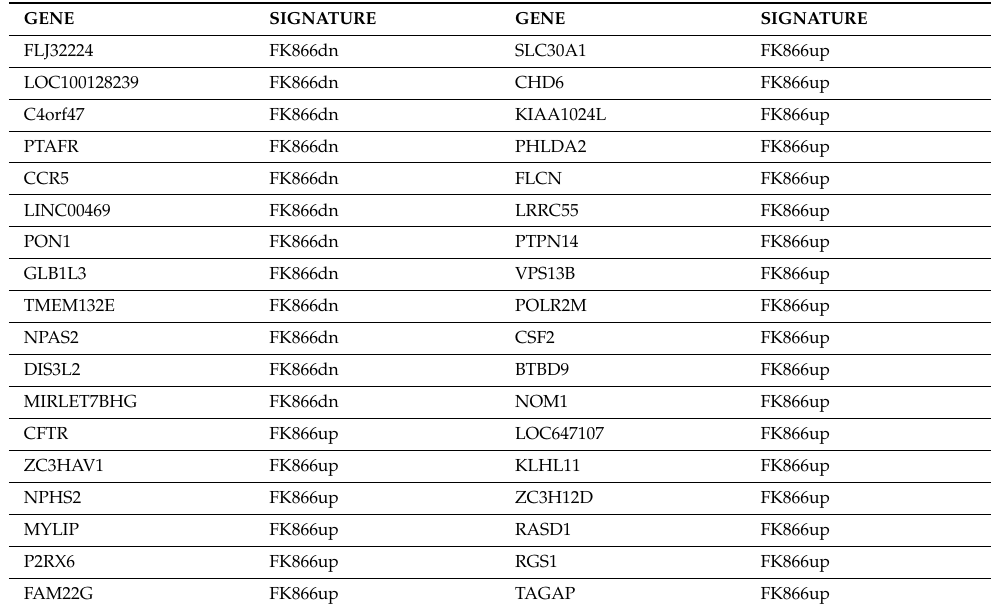
Figure 3. FK866 transcriptomic changes among CD38-overexpressing MM patients confers survival advantage. ( A ) Heatmap showing FK866 activity signature expression in NDMM patients derived from the CoMMpass dataset: a group of patients with gene expression in accordance with FK866 treatment is highlighted in the green rectangle (FK866 treated-like). ( B ) Kaplan–Meyer curves of the overall survival probability for FK866 treated-like patients were divided in quartiles for their expression of CD38. (FK866dn, signature created by FK866 down-regulated genes; FK866up, signature created by FK866 upregulated genes; CD38low, CD38 expression bottom quartile; CD38high, CD38 expression top quartile). Table 2. Genes up-regulated and down-regulated by FK866 treatment in GSE96636, used to build FK866 activity signature.